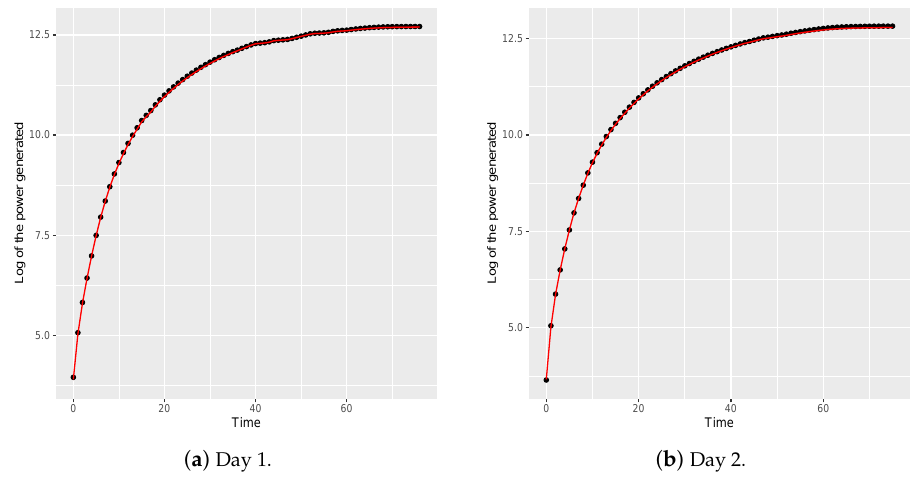
Figure 6. The recorded and predicted